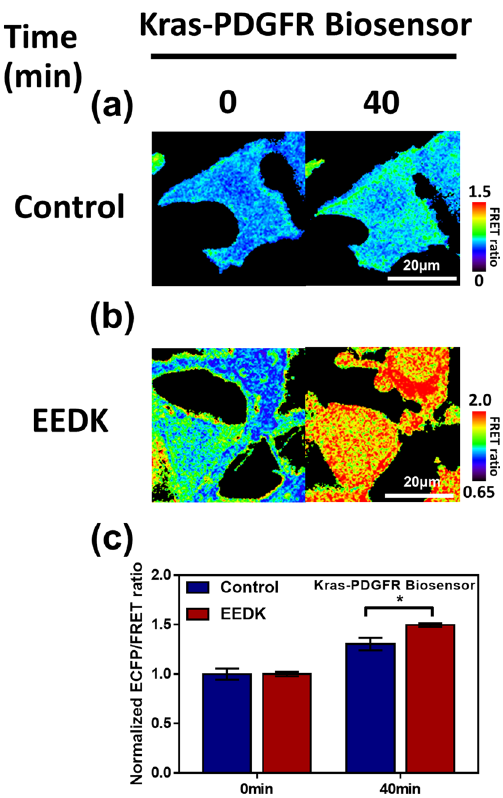
Figure 3. The effects of EEDK on PDGFR activity. ( a , b ) Time-lapse FRET images of the Kras-PDGFR biosensor in HEK293A cells exposed to the control (0.5% (v/v) DMSO) and EEDK (50 μg/mL). The colored scale bars represent the range of the ECFP/FRET emission ratios of the biosensors. Hot and cold colors indicate high and low PDGFR activity, respectively. Scale bar = 20 μm. ( c ) The bar graph describes the mean values of the normalized ECFP/FRET emission ratios of the biosensor at 0 min and 40 min. It contains error bars indicating the S.E.M (n = 7, * P < 0.05, Student’s t